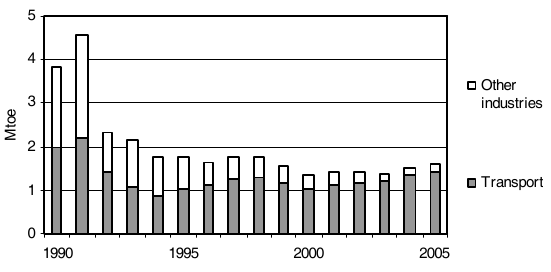
Fig 1. Trends of final consumption of petroleum